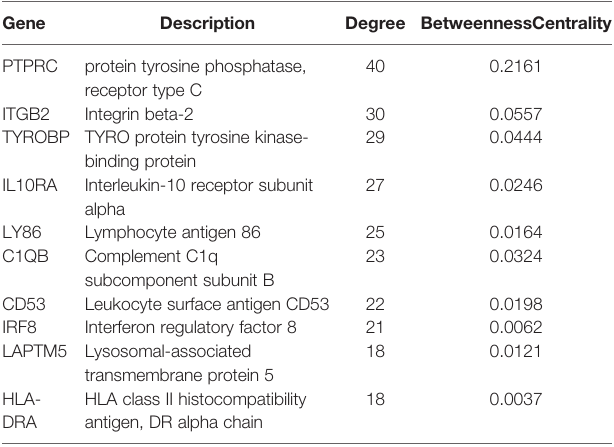
TABLE 2 | The top 10 hub genes identi fi ed and their